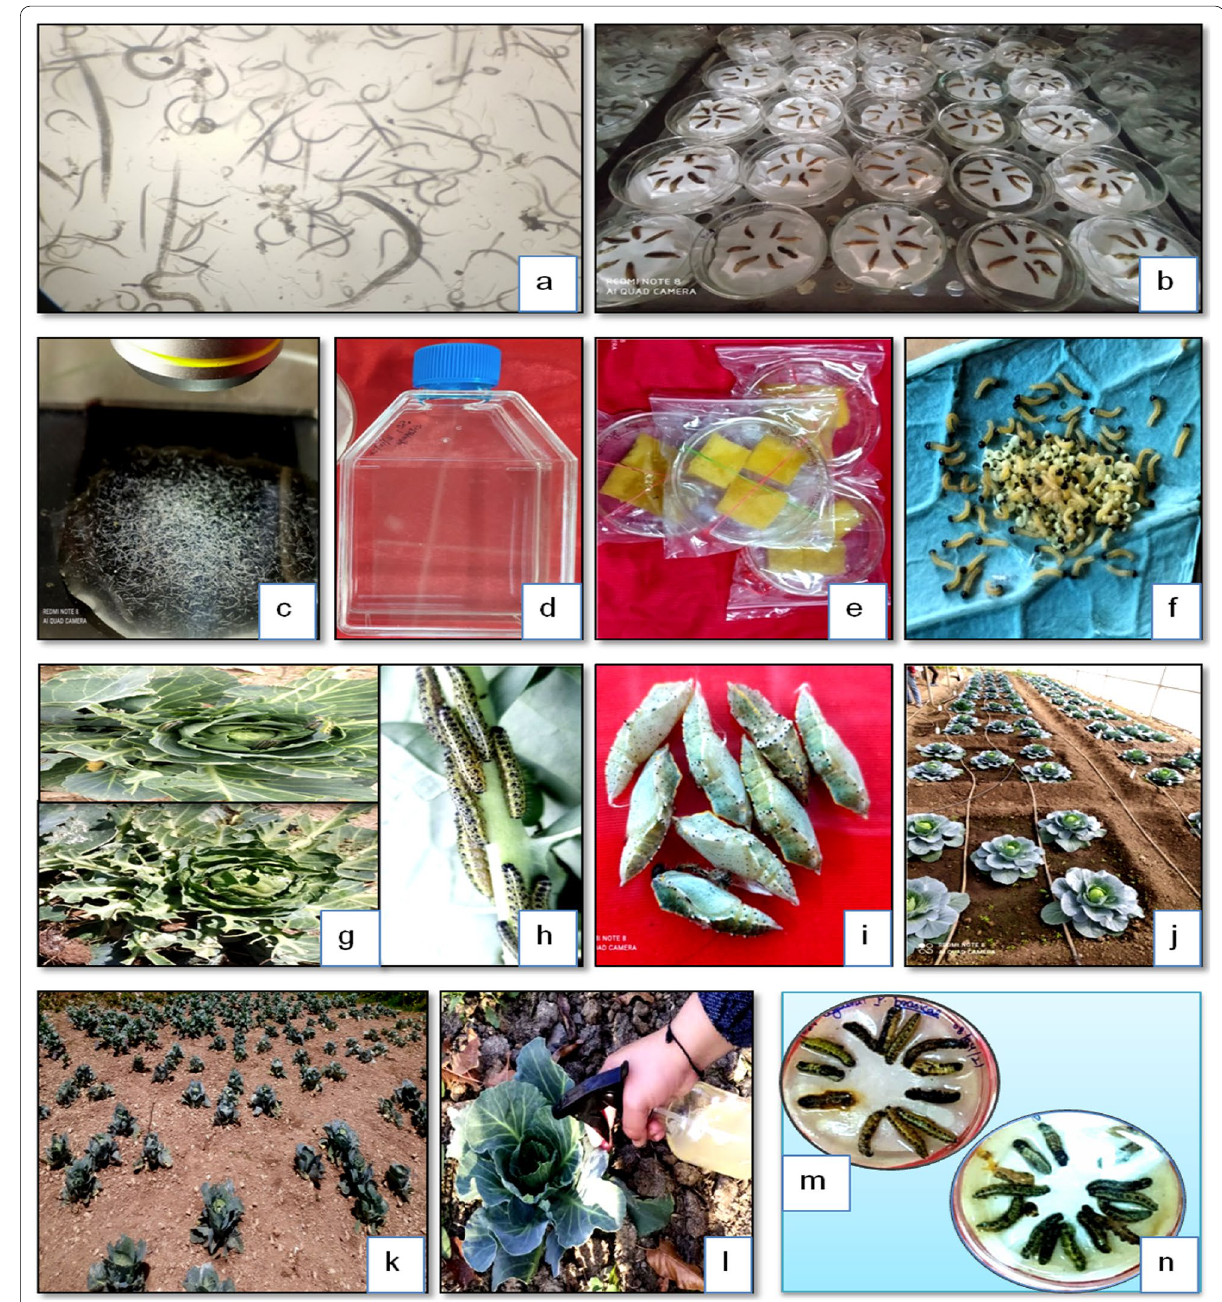
Fig. 5 Application of Heterorhabditis bacteriophora against Pieris brassicae in the laboratory and field condition a H. bacteriophora population; b Mass multiplication in the laboratory; c Multiplied nematodes; d , e Stored nematodes; f P. brassicae larvae; g , h P. brassicae larvae infesting cabbage; i P. brassicae pupae; j Polyhouse trial; k Field trial; l application of H. bacteriophora ; m , n Dead cadavers of P. brassicae collected from the polyhouse and